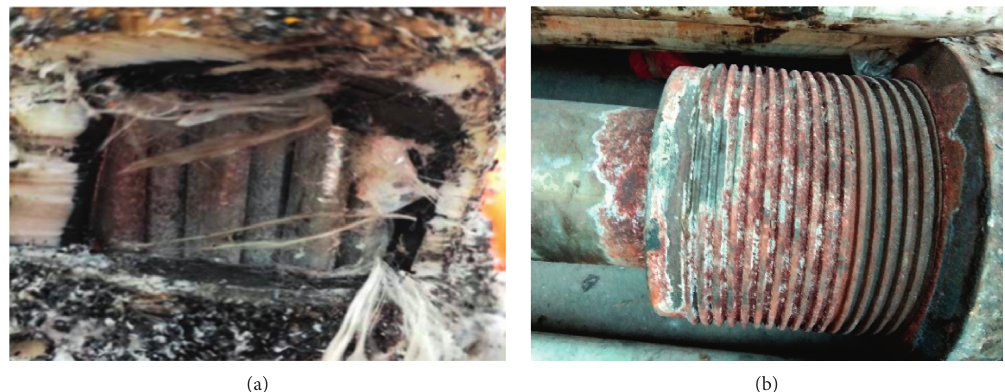
Figure 1: Corrosion inside the suspender: (a) corroded steel bundle; (b) corrosion in the anchor cup.